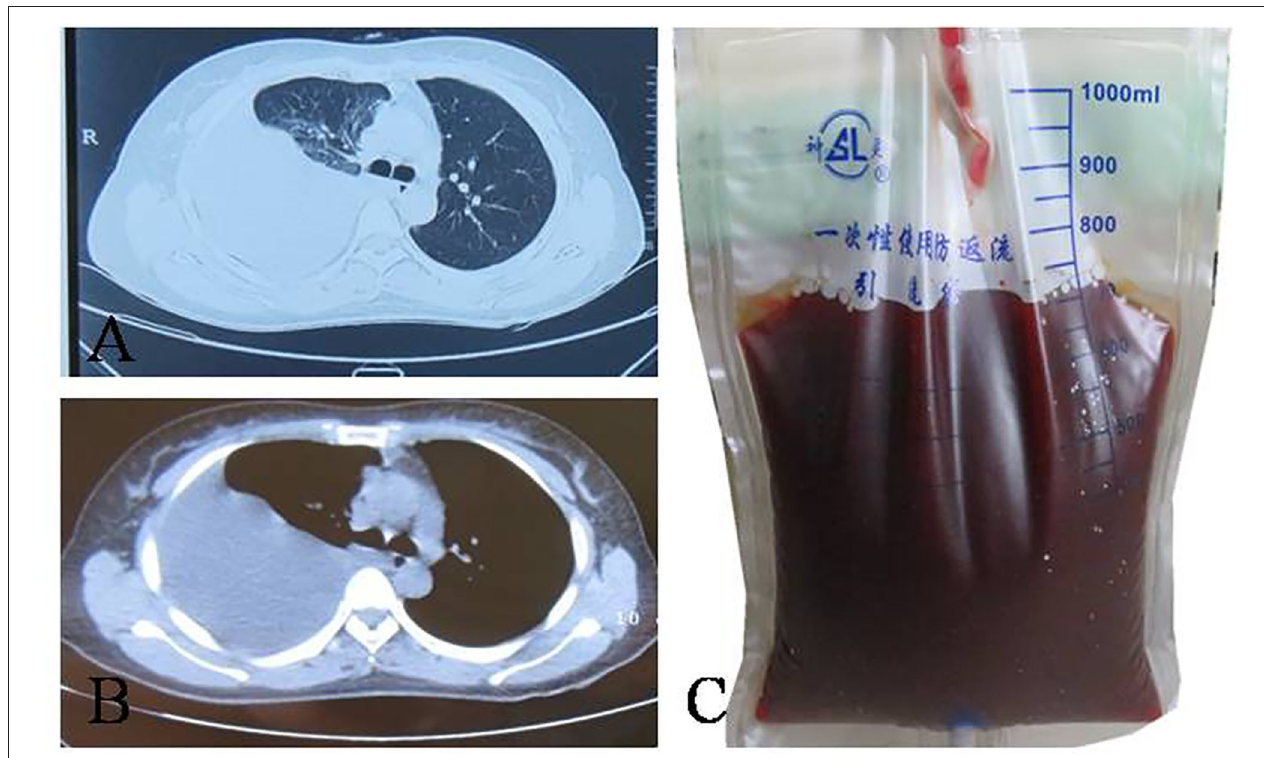
FIGURE 2 | Computed tomography manifestation and pleural fluid of the patient. (A,B) right-sided pleural effusion; (C) haemorragic fluid aspirated from right pleural cavity.